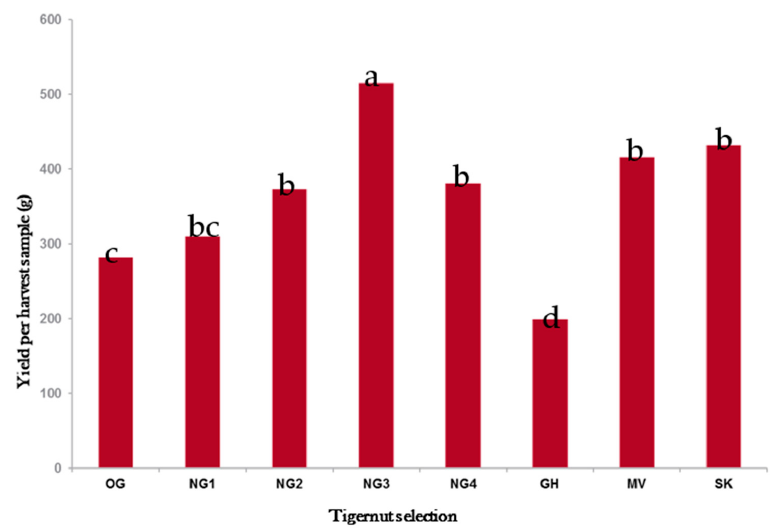
Figure 8. Combined tuber yield (g) in tigernut selections under black plastic mulch at Horticulture Farm 3, East Brunswick, Central NJ, and Rutgers Ag Research and Extension Center, Bridgeton, Southern NJ Bars show treatment means separated using the Tukey’s HSD at 5% significance level. Bars with similar letters are not statistically different.